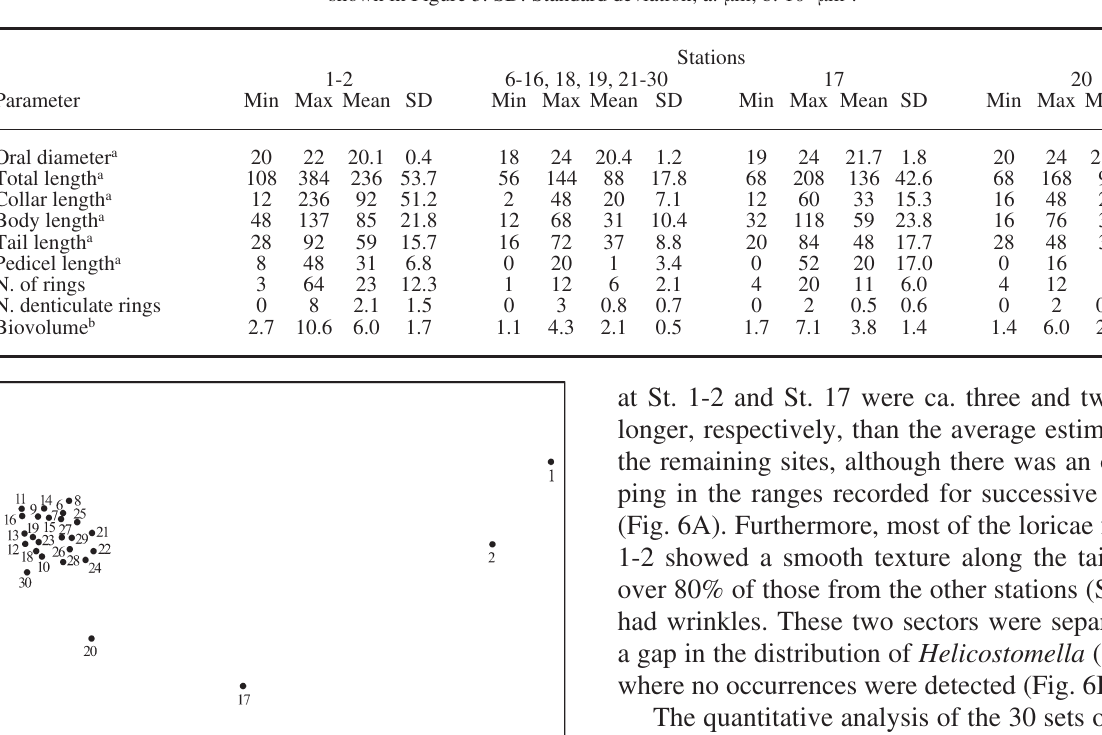
Table 1. – Morphological parameters of Helicostomella for stations and groups of stations obtained from the Multi-dimensional Scaling plot shown in Figure 5. Sd: Standard deviation; a: µm; b: 10 4 µm 3 .